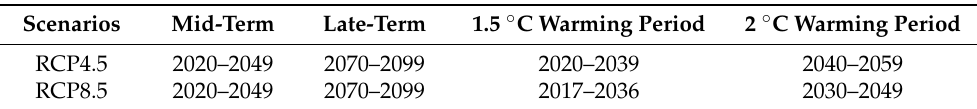
Table 1. The representative periods of the 21st century and the periods of 1.5 and 2 ◦ C warming under RCP4.5 and RCP8.5